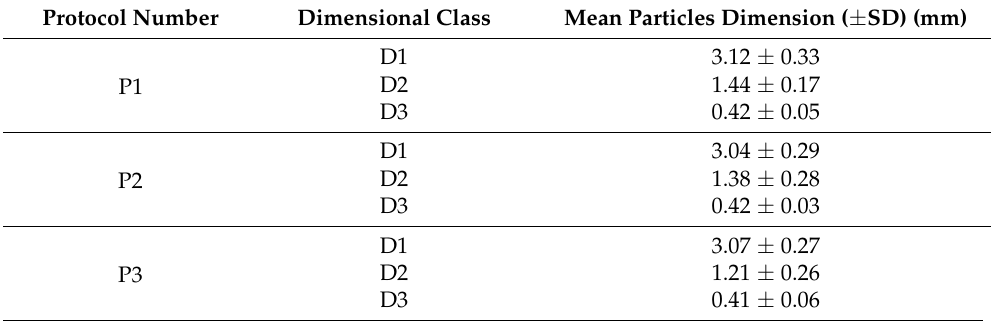
Table 1. Mean dimension of the particles added to the standard protocols: protocol 1, P1; protocol 2, P2; protocol 3, P3. The first dimensional class (D1) includes particles in the range 2–5 mm, the second (D2) in 500–2000 µ m, and the third (D3) in 250–500 µ